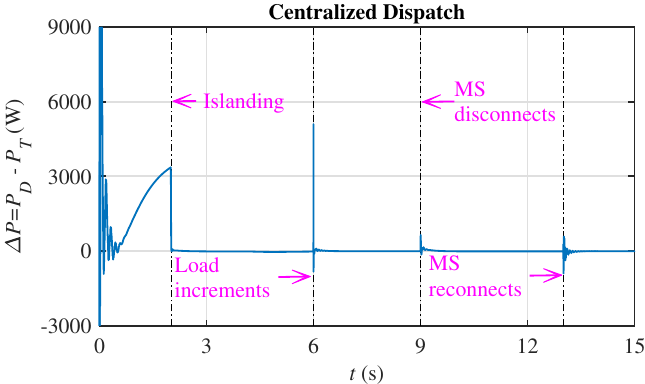
Figure 13. Power